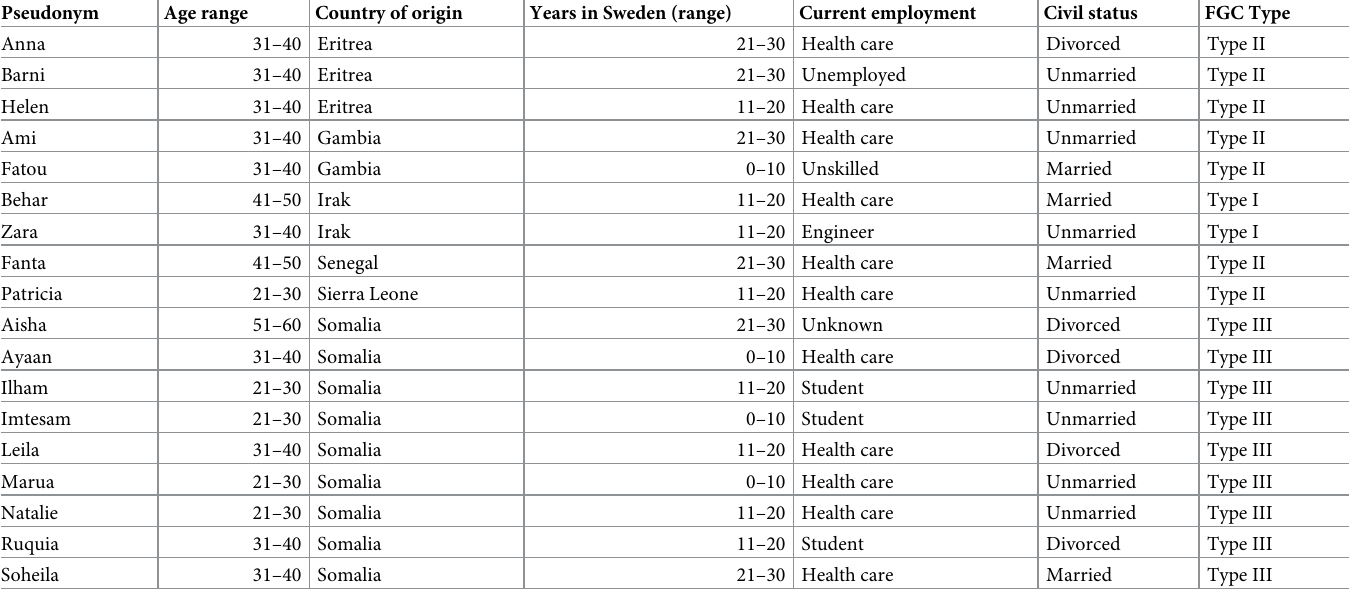
Table 1. Characteristics of women having undergone CR in